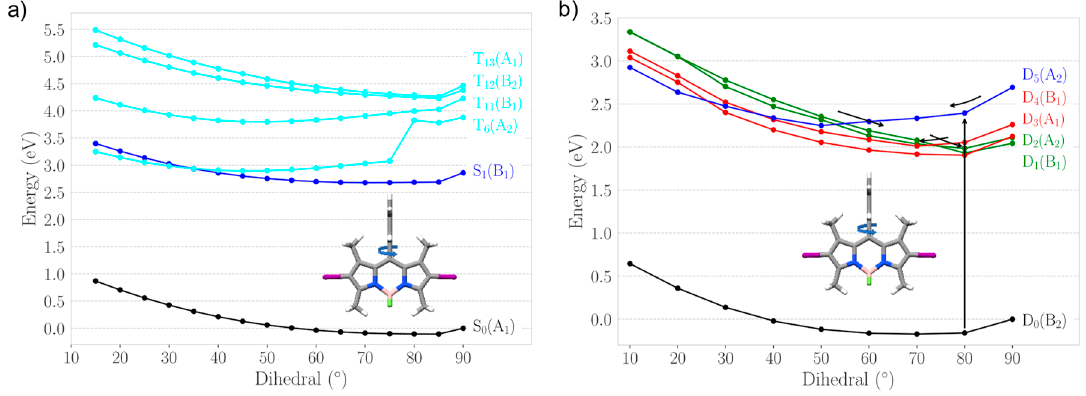
Figure 2. Relaxed TDDFT scan around a dihedral connecting the two aromatic ring systems for 1 1 0 ( a ) and 2 1 − 1 ( b ). Arrows indicate a possible relaxation pathway starting from the bright D 5 state in 2 1 − 1 . Colour code: ground state (black), bright excited singlet/doublet state (blue), triplet CT states (cyan), dissociative doublet state (red), CT doublet state (green).